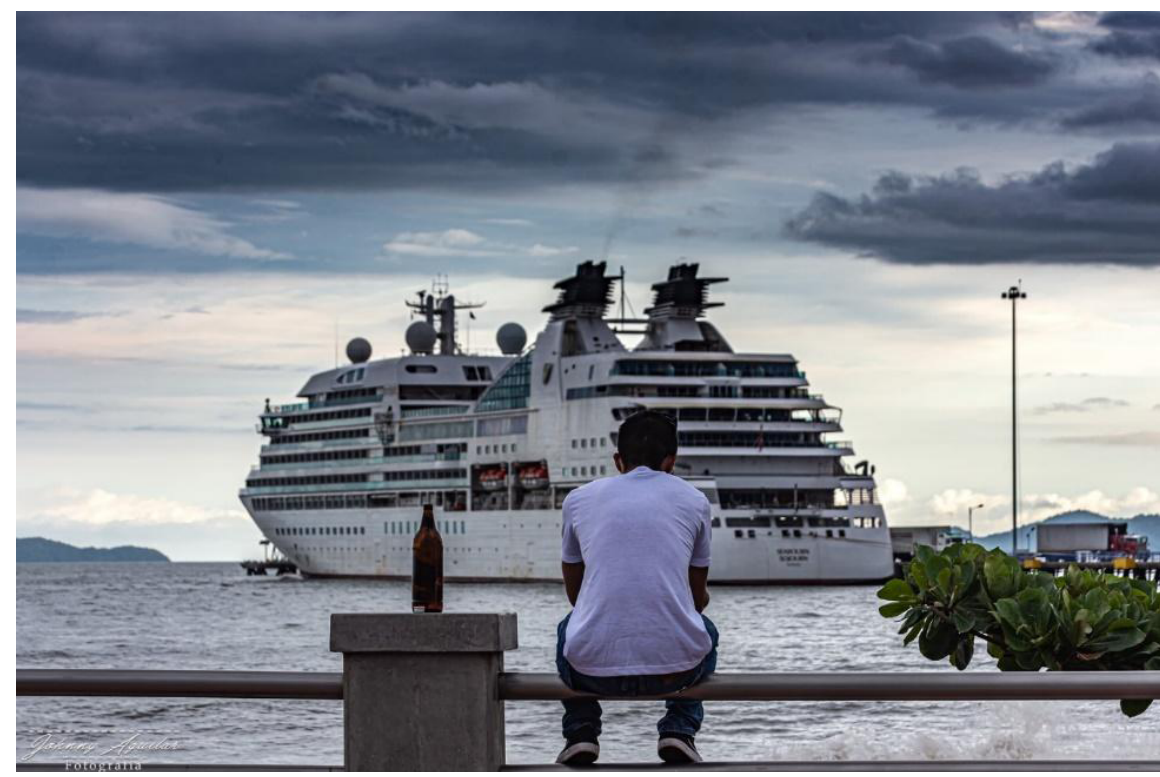
FIG. 1 Young man in front of a cruise ship, ©Johnny